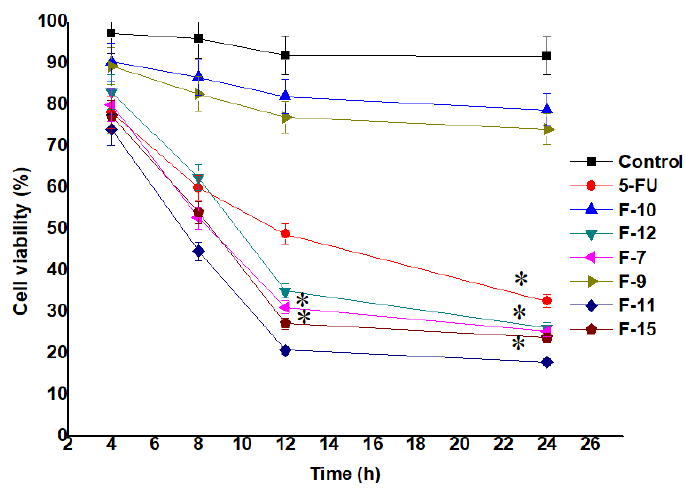
Figure 5. Viable cells (MCF-7 cells) treated (at their IC 50 ) with the formulations and drug solution (MTT assay). Data presented as mean ± standard deviation ( n = 3). * Indicates statistically significant inhibition as compared to control ( p < 0.05).